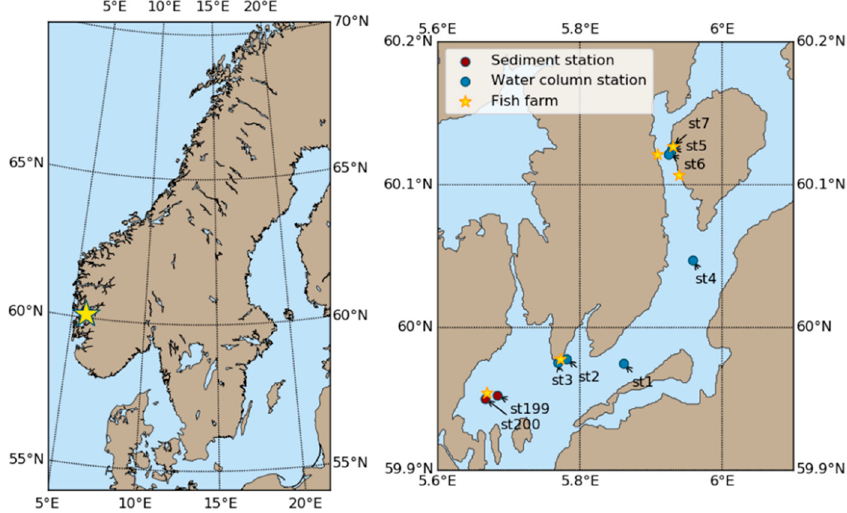
Figure 4. Position of stations during the cruise to the Hardangerfjord 25–26 August 2016.